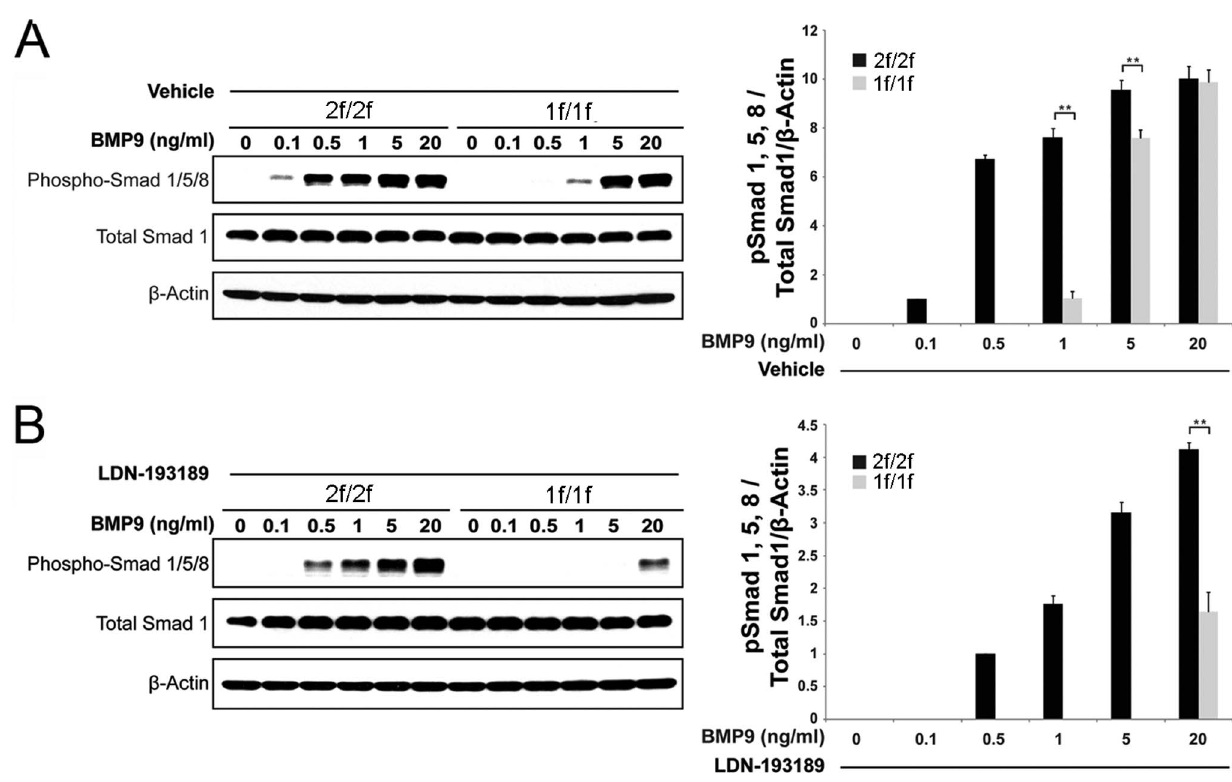
Figure 5. LDN-193189 treatment efficiently block BMP9 mediated SMAD1/5/8 phosphorylation in 1f/1f-ECs. 2f/2f- and 1f/1f-ECs were deprived of serum for 24 hours in chemically defined growth factor- and serum-free ECM, and cells were treated with solvent control (PBS, pH 7.4 with 2% 2-hydroxypropyl-b-cyclodextrin; A) or LDN-193189 (100 nM; B) 2 hours prior to treating cells with BMP9 (0, 0.1, 0.5, 1,5, or 20 ng/ml) for 30 minutes. b -Actin was used as a loading control. Histogram shows phospho-SMAD1/5/8 normalized by total SMAD1 and b -Actin relative to the value indicated by asterisks. Data in all graphs represent means of values measured by densitometry from three separate blots. Error bars are SDs (** p , 0.01